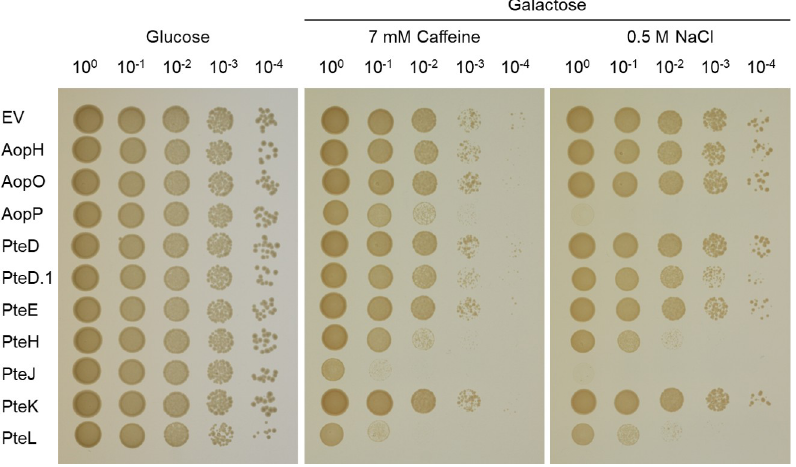
Fig 3. Yeast growth inhibition assay under stress conditions. Strains carrying putative T3SS effectors cloned into pGREG533 were grown overnight in SDM-His-Glu, washed and 10-fold serially diluted. Aliquots from each dilution (10 μ l) were spotted onto SDM-His-Glu or on SDM-His-Gal plates containing either 0.5 M NaCl or 7 mM caffeine. The strain containing pGREG533 was used as a negative control and showed no growth inhibition. The plates were incubated at 30˚C for 2–3